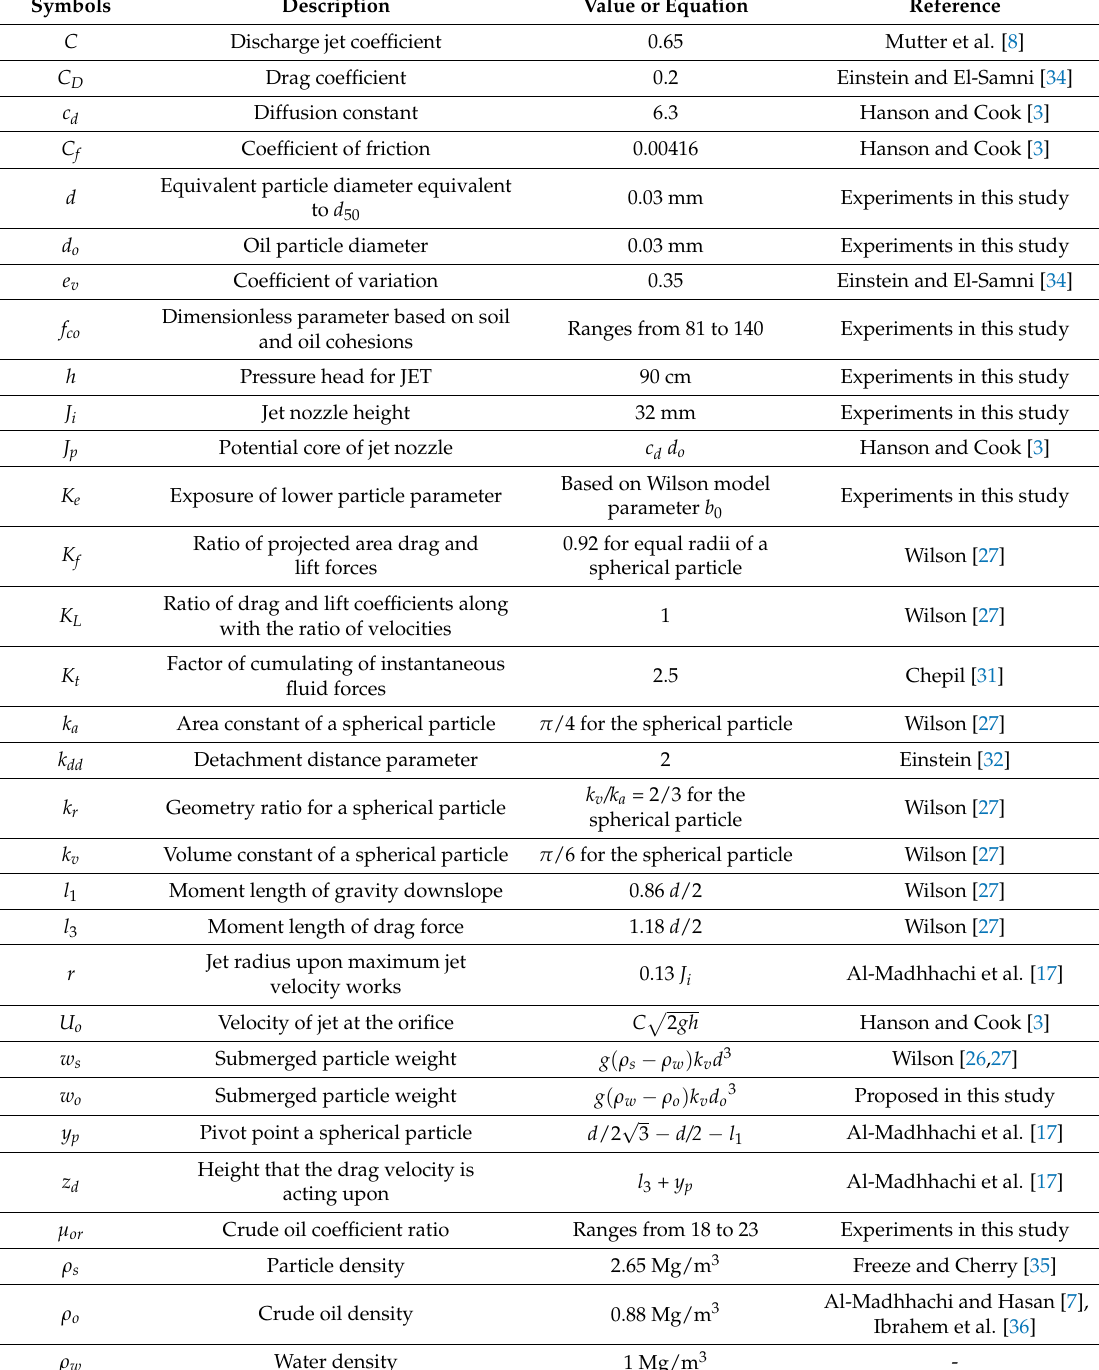
Table 1. Definition of parameters in the Wilson model obtained from soil contaminated with crude oil.